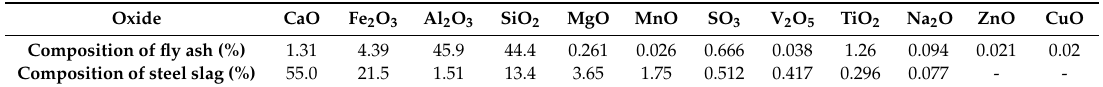
Table 1. Percentage of oxides in waste residue substrate.